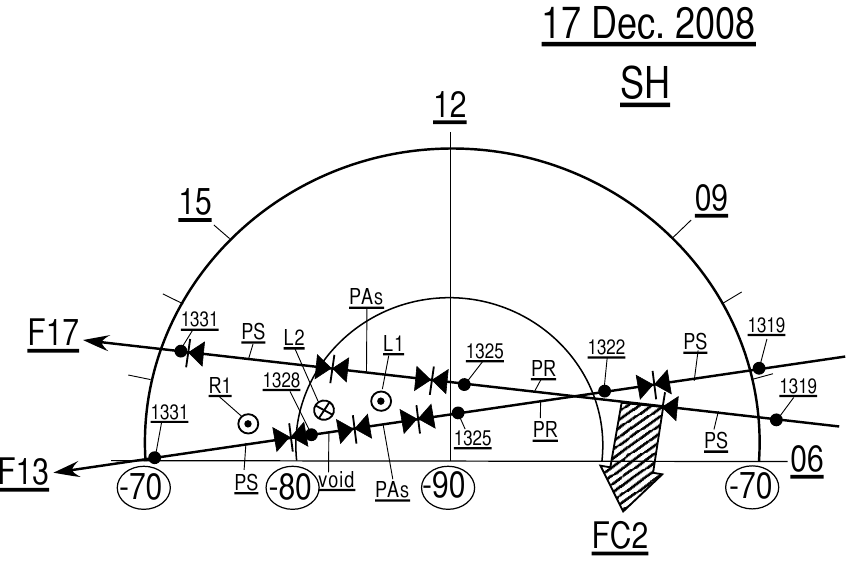
Fig. 6. Tracks of spacecraft DMSP F13 and F17 across the polar cap from dawn to dusk in the Southern Hemisphere (SH) during the interval 13:20–13:30UT shown in MLT/MLAT coordinates. Regimes of particle precipitation (PS; PR; PAs; void), and Birkeland currents (R1; L1; L2) along the tracks are indicated. Flow channel FC 2 on the dawn side (07:00MLT; 78 ◦ MLAT) as detected by S/C F17 is marked by hatched arrow. The sector called “void” marks the dropout of polar rain in the regime of sunward convection (lobe cell) on the dusk side of the polar arcs (PAs) in the F13